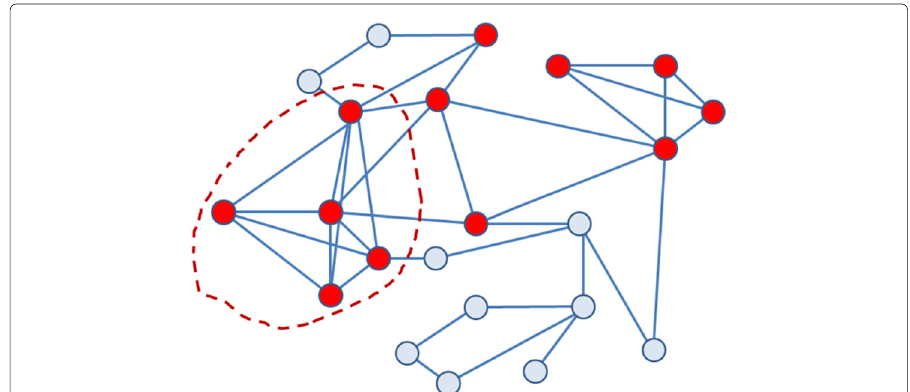
Fig. 3 Example community of red highlighted nodes that exhibit triadic closure (i.e. form triangles). The circled clique is tightly connected and hence would likely be favored by high level unsupervised structural community quality